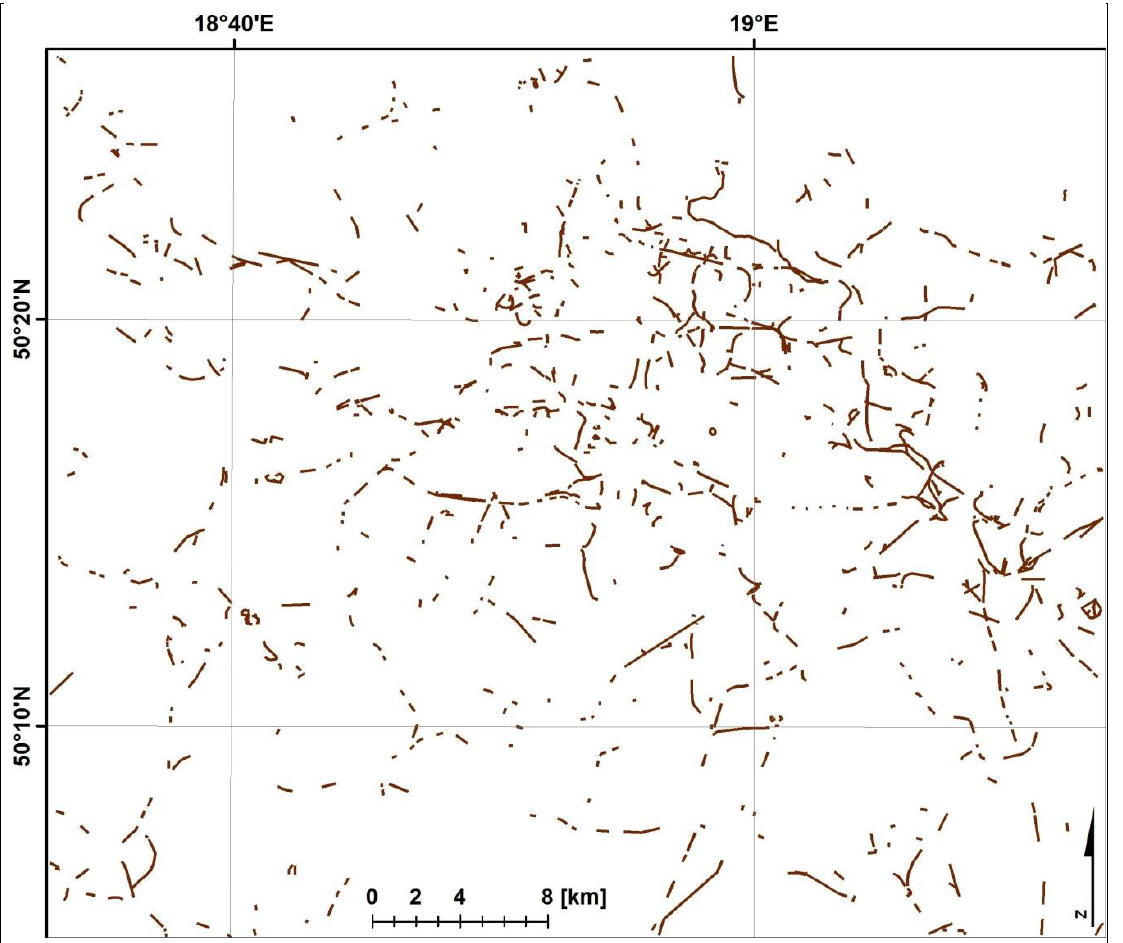
Fig. 2. Spatial distribution of analysed line